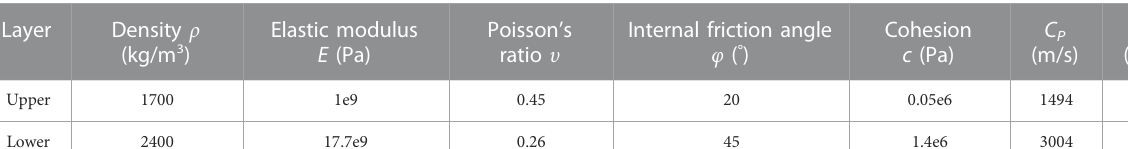
TABLE 1 Material constants of the soil.